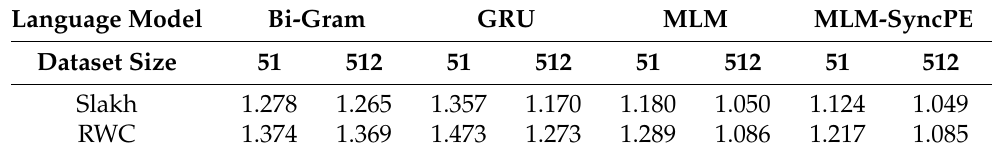
Table 4. Perplexities obtained by the language models. “MLM” and “MLM-SyncPE” are MLMs with the conventional and proposed tatum-synchronous positional encodings,